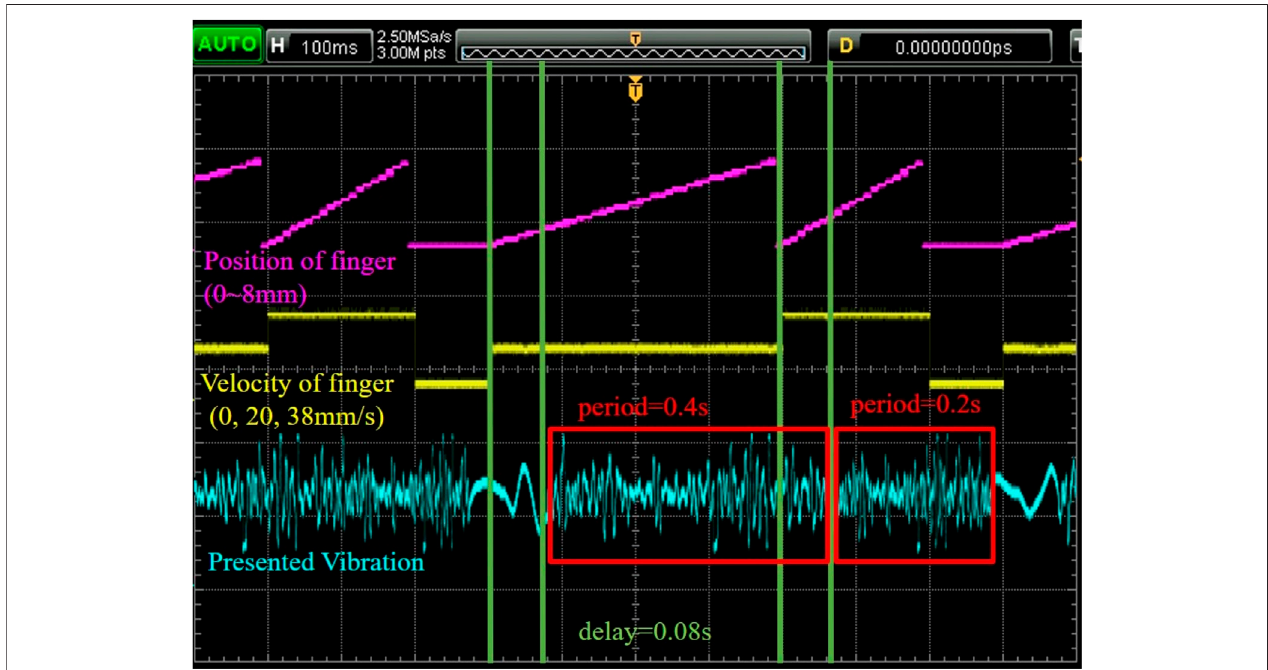
FIGURE 9 | Time relative relationship with fi nger position, velocity, and vibration playback speed.